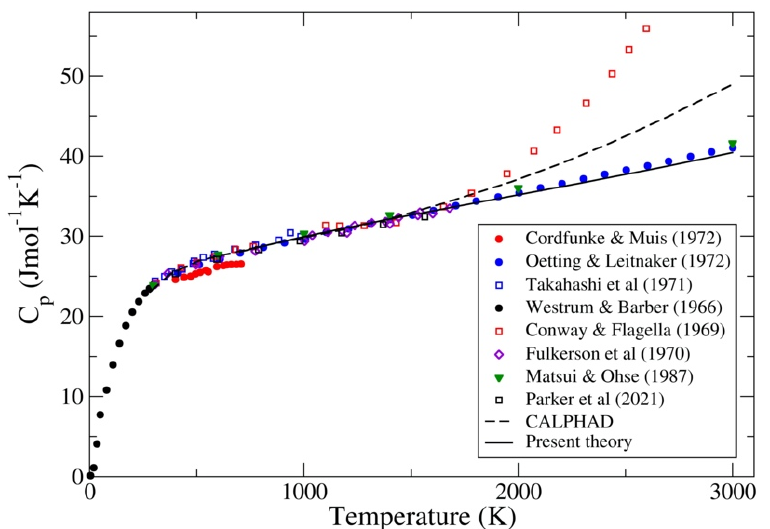
Figure 8. Specific heat at constant pressure, C p , for UN. Present theory is here indicated by the solid line. Experimental data are from [7,67–73] and CALPHAD data are shown with a dashed line.